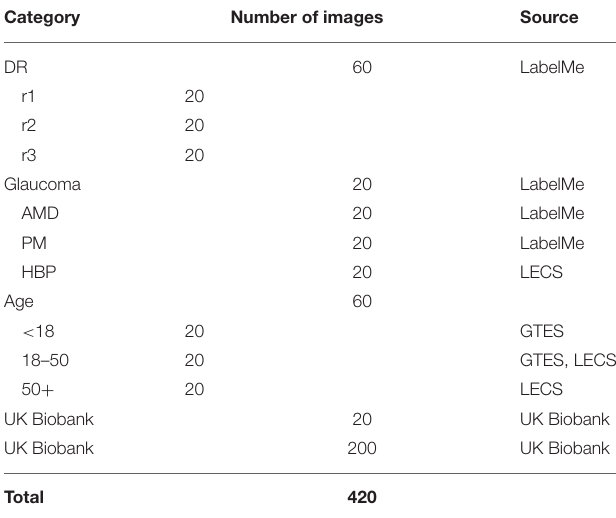
TABLE 1 | The composition of the newly-built dataset for retinal artery, vein, and optic disc segmentation. LECS, Lingtou Eye Cohort Study; GTES, Guangzhou Twin Eye